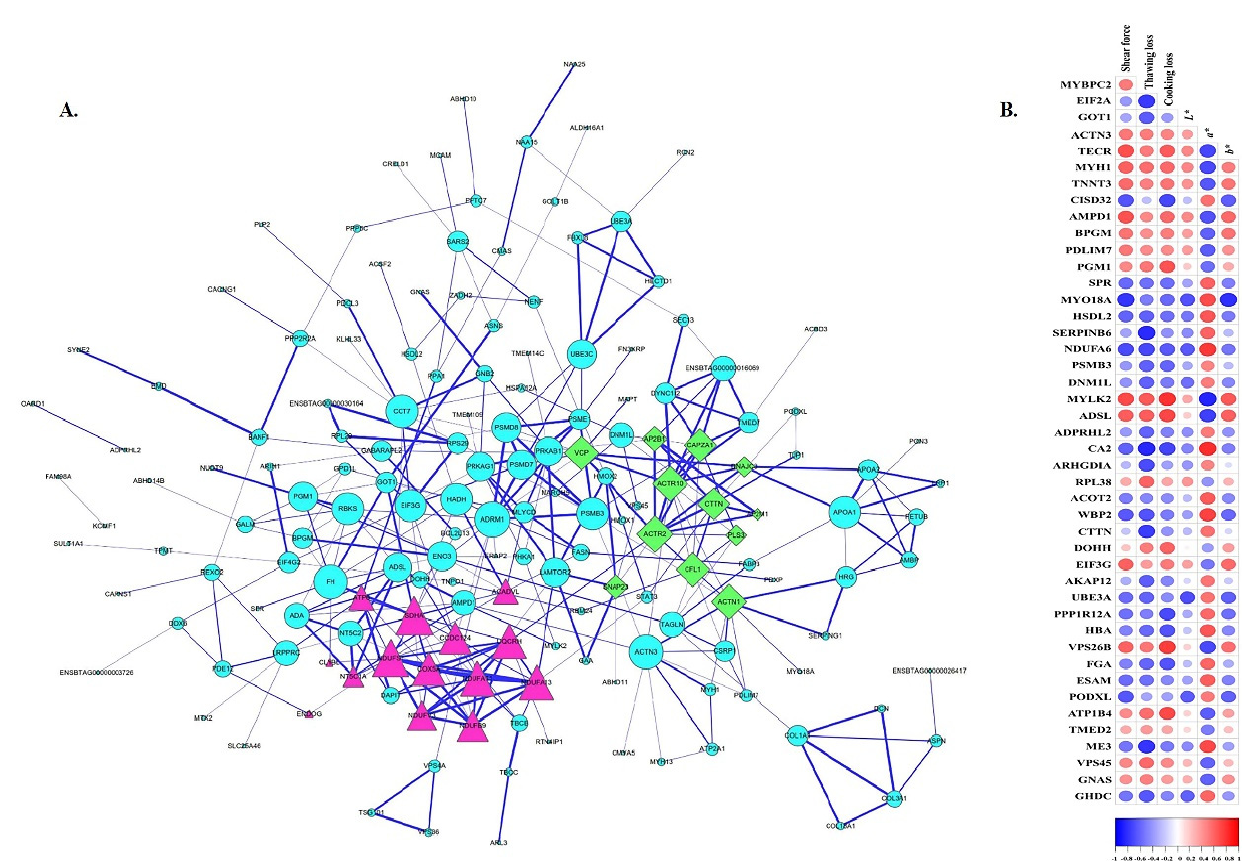
Figure 4. ( A ) Protein–protein interaction (PPI) network of the total DAPs. ( B ) A diagram of proteins correlated with at least one quality indicator (r > 0.60; p < 0.05).